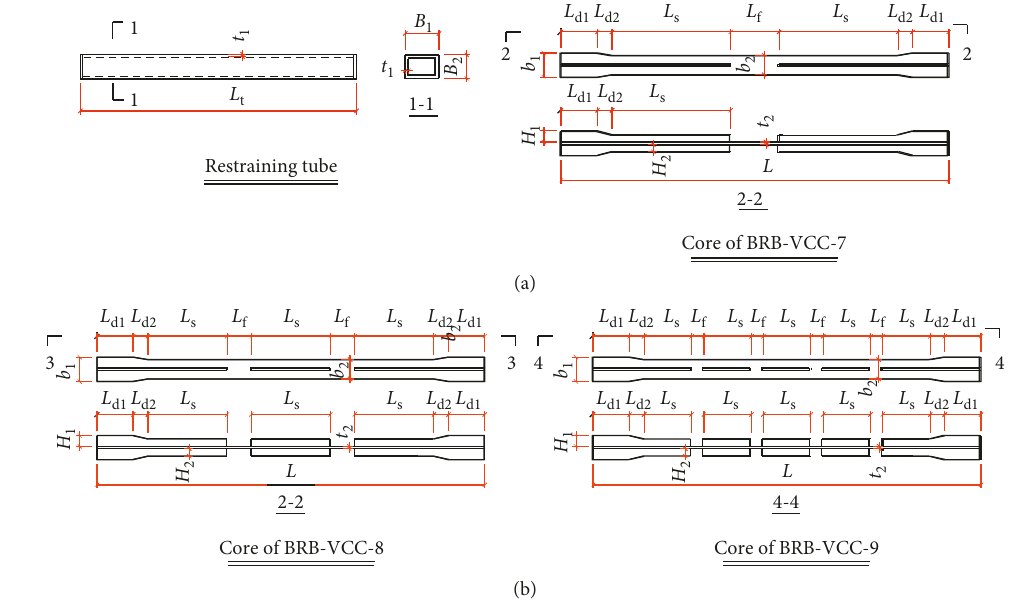
Figure 15: Model details. (a) BRB-TJ-I. (b) BRB-VCC. Table 5: Design parameters of models (unit: mm).